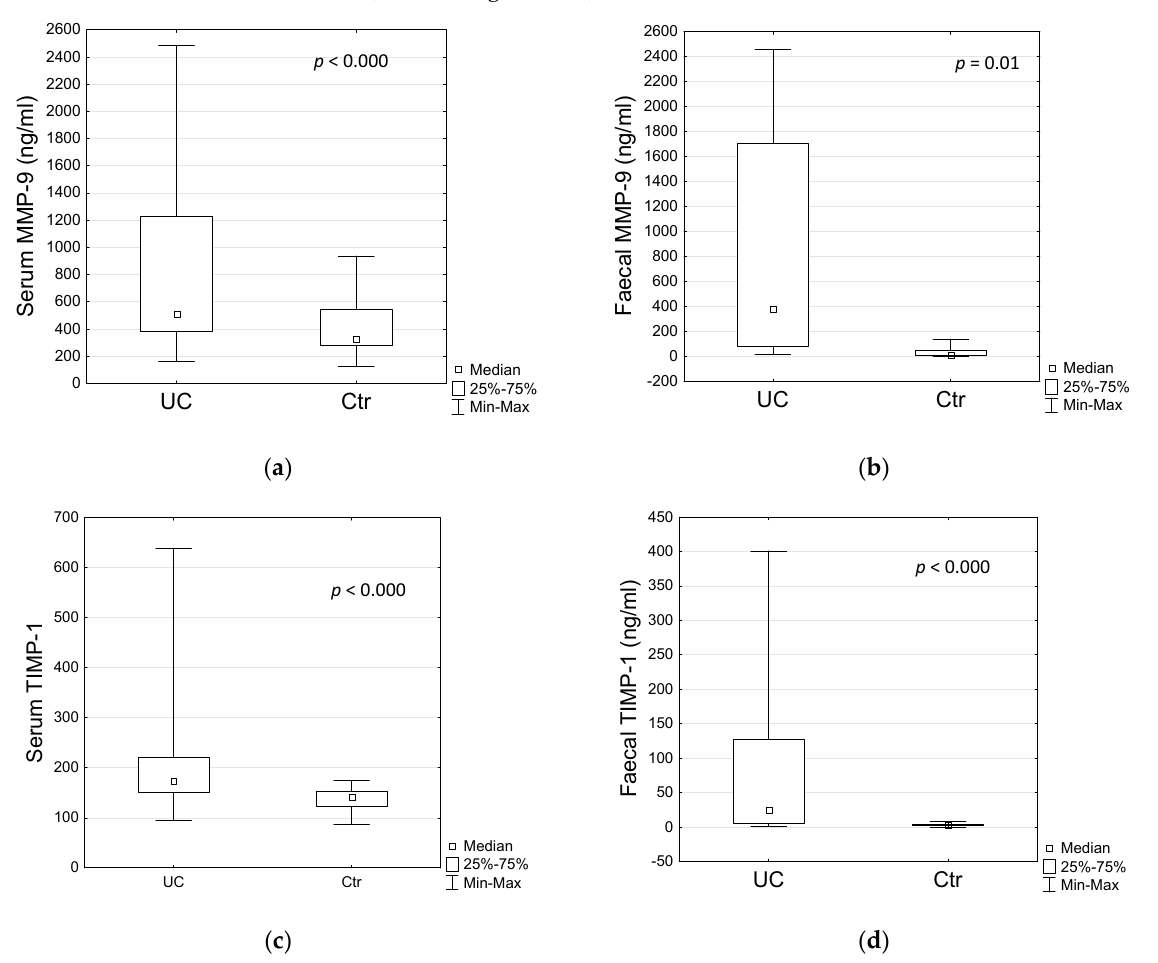
Figure 1. Serum and faecal MMP-9 ( a , b ) and TIMP-1 ( c , d ) concentrations in UC and Ctr groups.